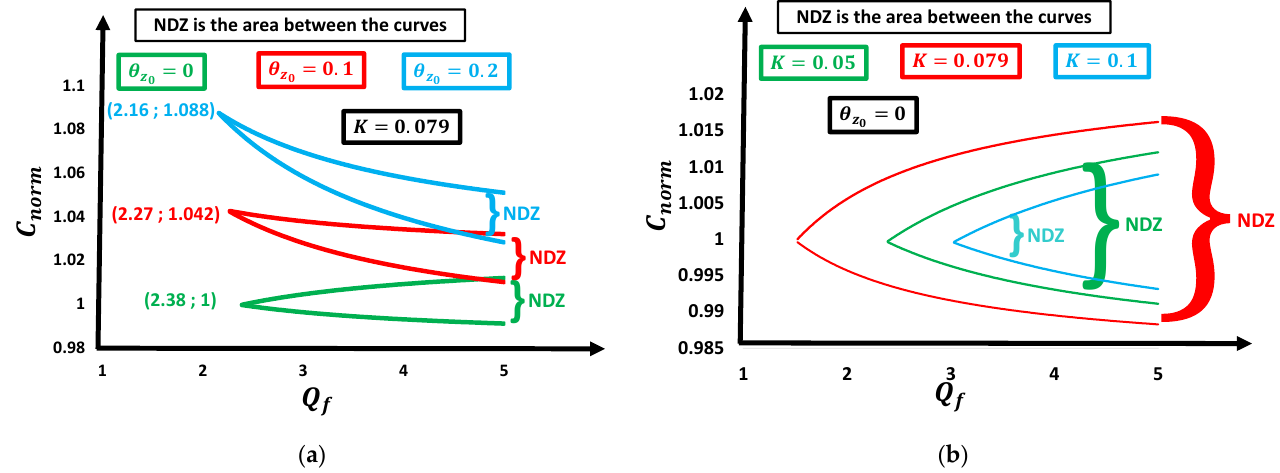
Figure 9. APJPF NDZ: ( a ) APJPF NDZ mapping for different values of 𝜃 𝑧 APJPF NDZ mapping for different values of 𝐾 and 𝜃 𝑧